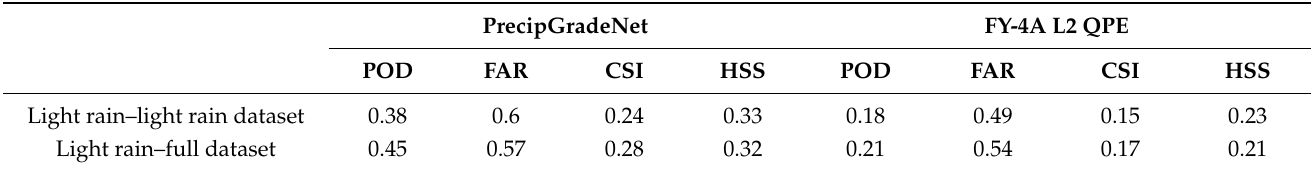
Table 12. Summary of the PrecipGradeNet and FY-4A L2 QPE detection performance of light rain in light rain dataset and full dataset. PrecipGradeNet FY-4A L2 QPE POD FAR CSI HSS POD FAR CSI